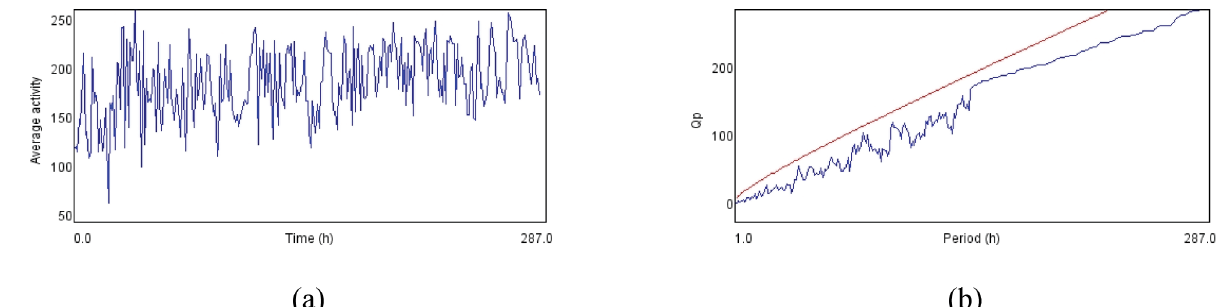
FIGURE 9S - (a) and (b) shows the average activity pattern and chi-square periodogram respectively for Control flies exposed to luteolin (25 µM).